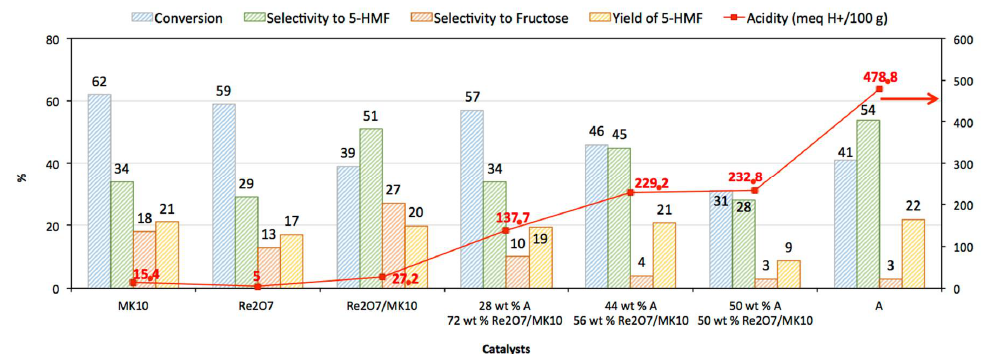
Figure 6. Catalytic activity of physical mixtures A-Re 2 O 7 /MK10 in different wt % proportions compared to A, MK10, Re 2 O 7 and Re 2 O 7 /MK10 catalysts. Reaction conditions: 2.4 g of glucose, 0.6 g of catalyst mixture, catalyst/glucose wt ratio = 0.25, solvent volume ratio (THF:H 2 O) = 35:15, temperature = 140 °C and reaction time = 4 h.